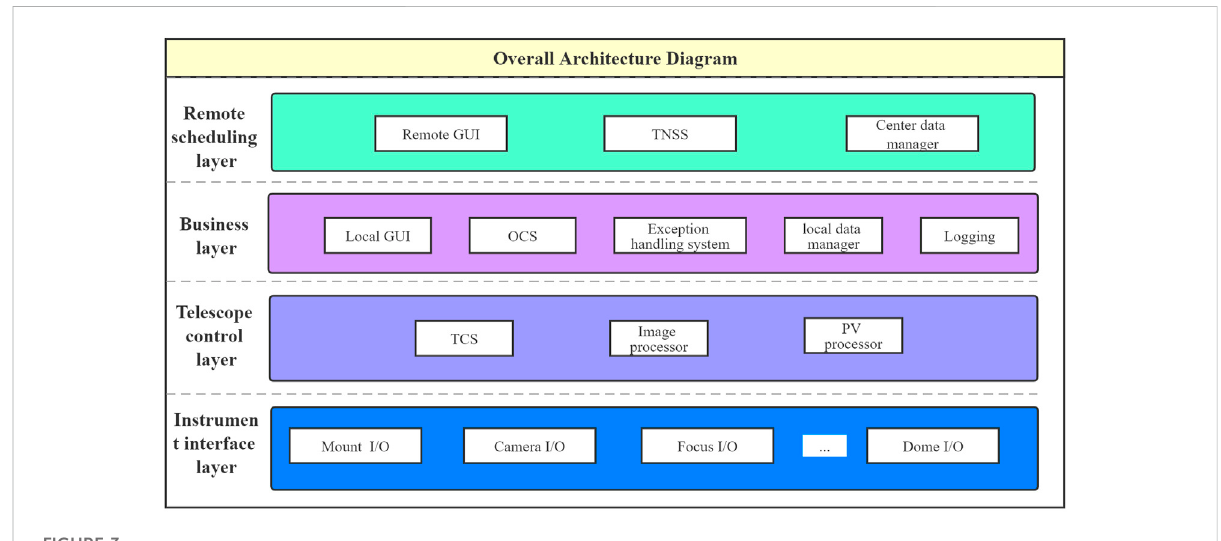
FIGURE 3 The overall architecture diagram.